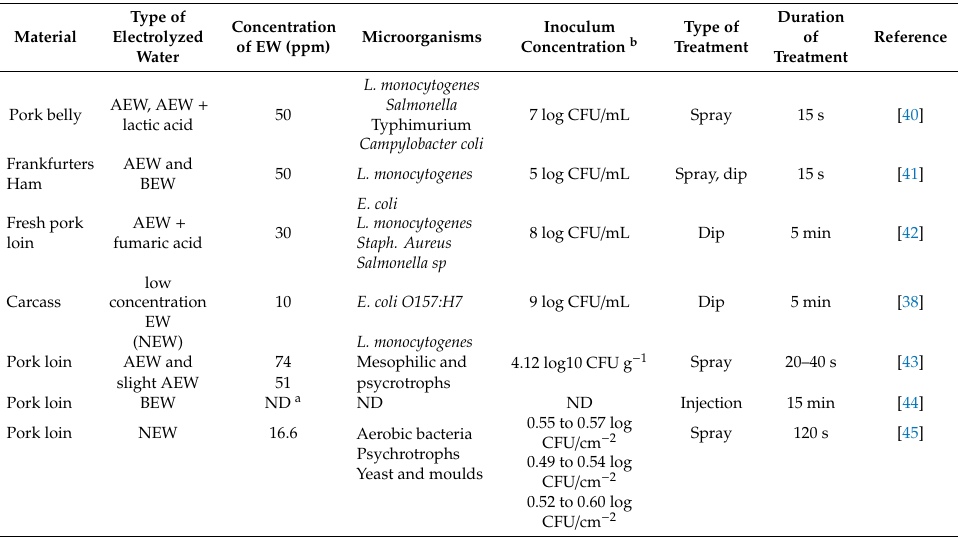
Table 2. Evaluations of electrolyzed water in